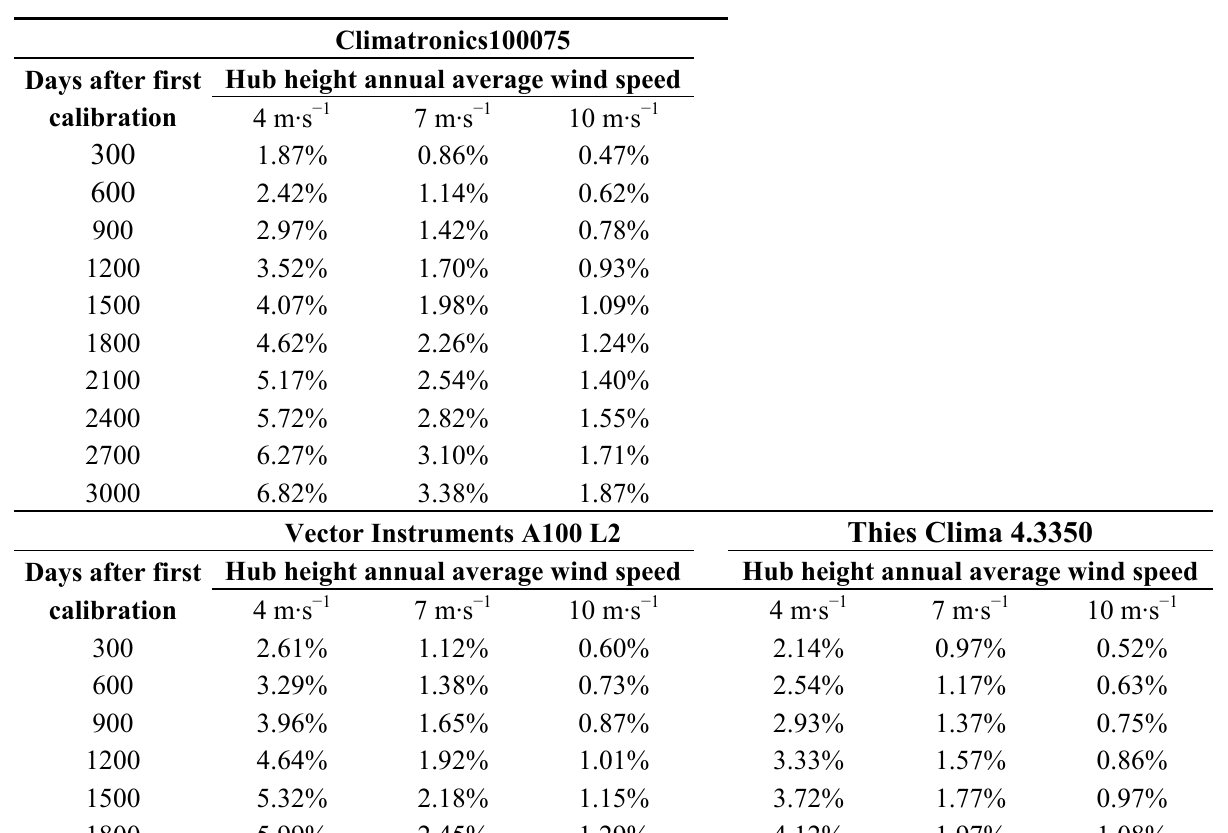
Table 5. Underestimation of the Annual Energy Production (AEP) caused by the deviation in the wind speed measurement due to the loss of performance of the IDR/UPM Climatronics100075, Vector Instruments A100 L2 and Thies Clima 4.3350 anemometers. AEP related to General Electric GE2.5. Underestimation calculated with 84.1% confidence